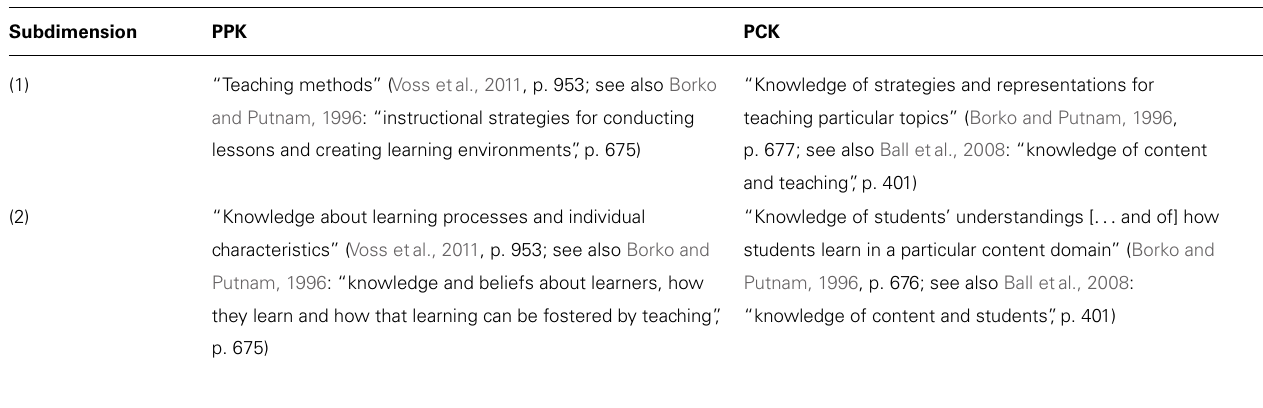
Table 1 | Overview of the subdimensions focused in the learning environments.